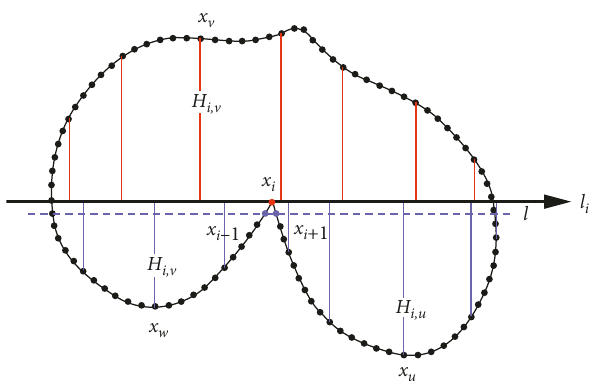
Figure 1: The Height Functions for the sample point x